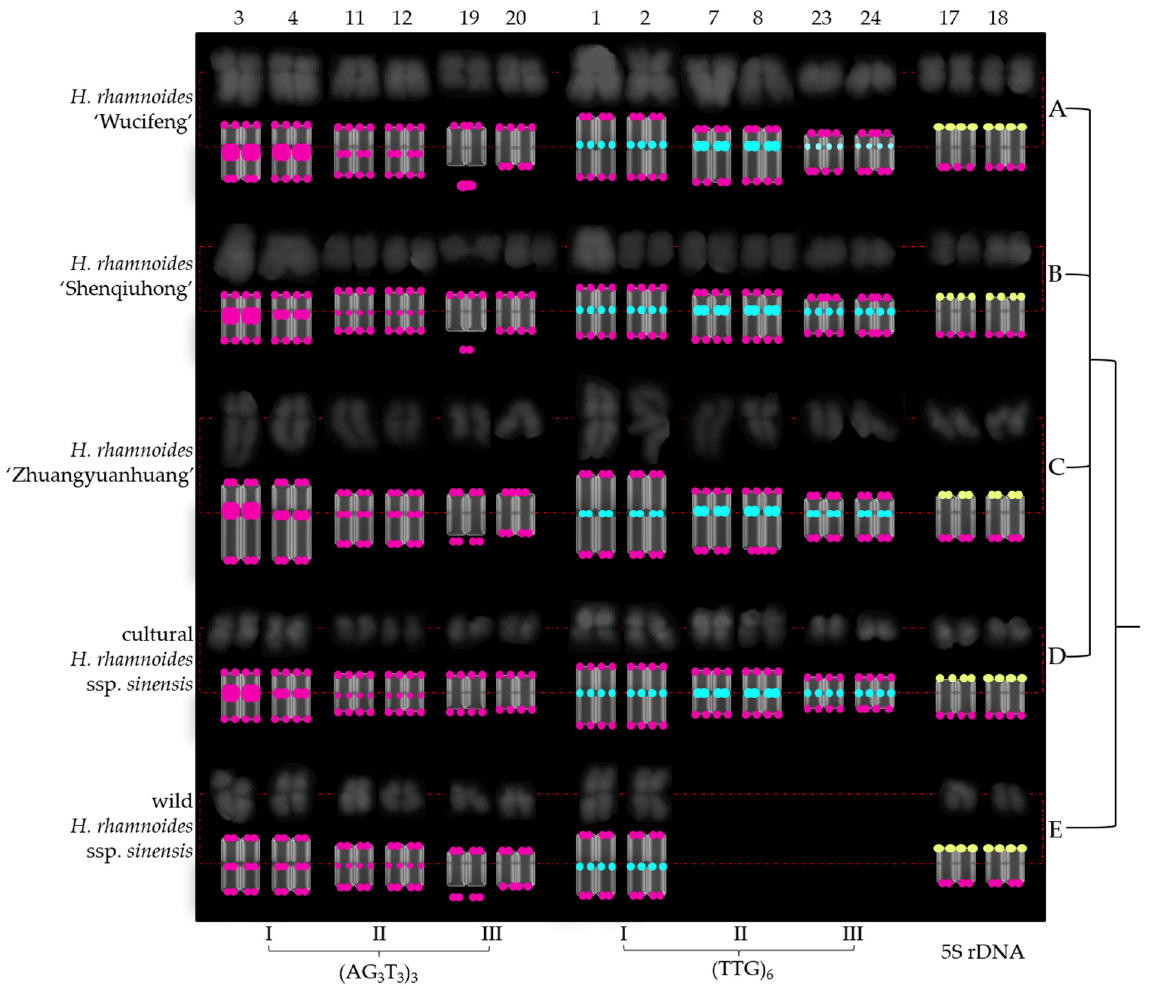
Figure 8. Physical map of Hippophaë rhamnoides . ( A ) Hippophaë rhamnoides ‘Wucifeng’, ( B ) H. rham- noides ‘Shenqiuhong’, ( C ) H. rhamnoides ‘Zhuangyuanhuang’, ( D ) cultural H. rhamnoides ssp. sinensis , and ( E ) wild H. rhamnoides ssp. sinensis . In order to better exhibit the centromere location, each chromosome in black–white was another version of the chromosome in blue in Figure 6. The red dotted line indicates centromere location. Small chromosomes with dim centromere location were aligned by the subtle clues and traces of chromosome white/black contrast. Therefore, determination of their centromere location is difficult. The signal pattern ideograms were constructed based on the above black–white chromosome and signal patterns of chromosomes in Figure 6. The numbers on the upper side represent chromosome number and the (AG 3 T 3 ) 3 , (TTG) 6 , and 5S rDNA signal types at the bottom are consistent with H. rhamnoides in Figure 6.